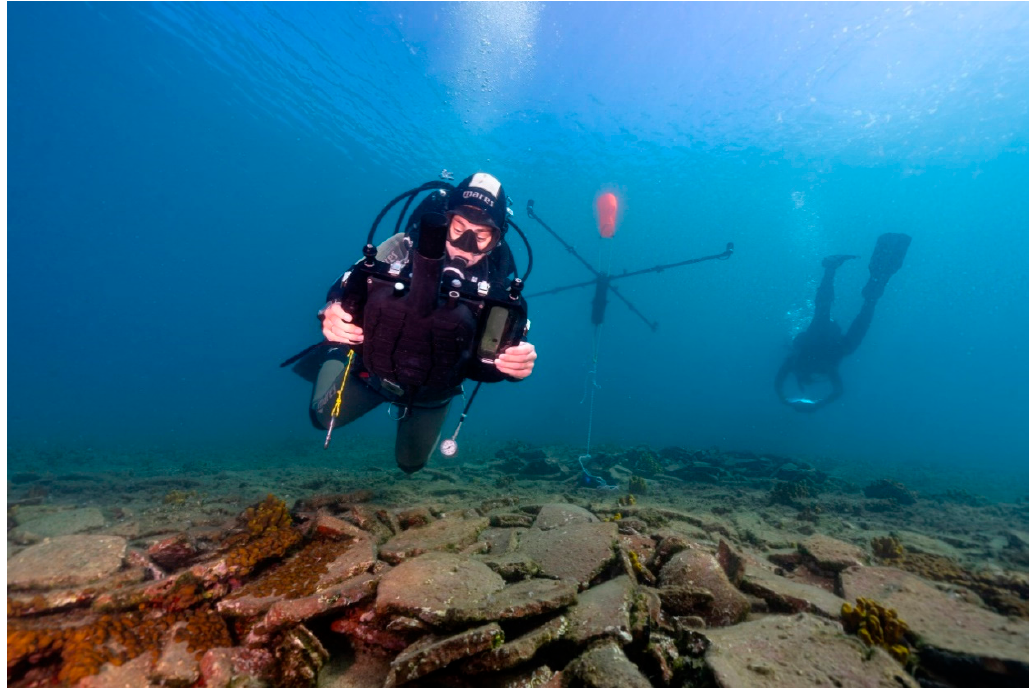
Figure 13. Divers that use the Augmented Diving system in the underwater archaeological site of “Kikinthos” shipwreck ©MCS-EUA, photo by Matteo Collina, Università della Calabria—DIMEG.